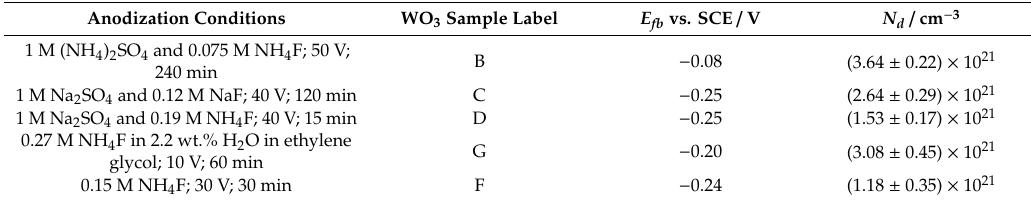
Table 3. Estimated flat band potentials ( E fb ), donor densities ( N d ) of WO 3 obtained in various anodizing conditions and annealed in air at 500 ◦ C for 2